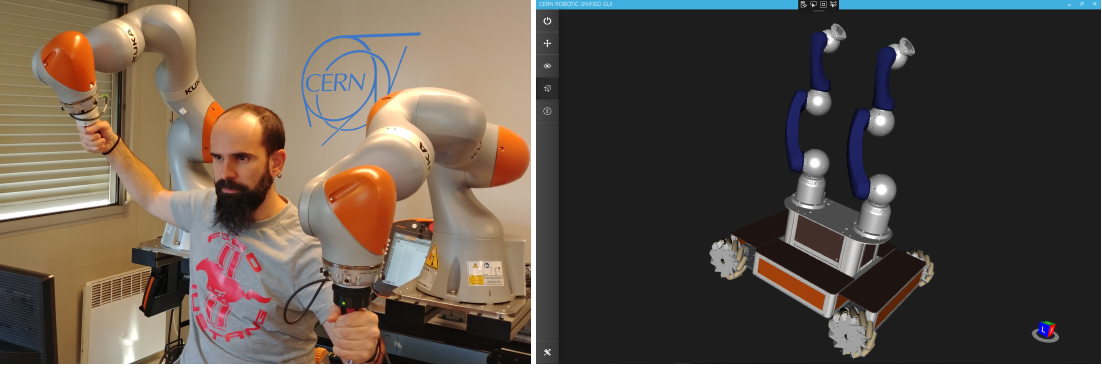
Figure 7. Human-Robot Interface (HRI). components for dual-arm configuration: ( left ). dual-arm master–slave and ( right ) 3D representation of the robot state in the